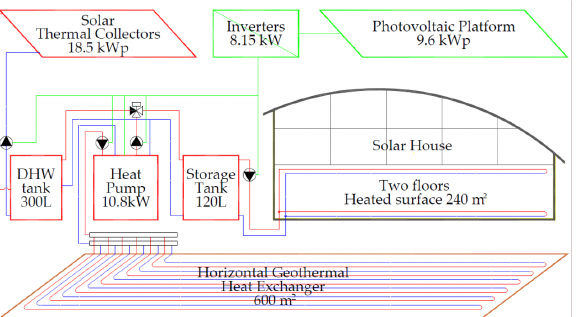
Figure 4. The connections between the components of the renewable energy systems supplying thermal and electrical energy to the Solar House.